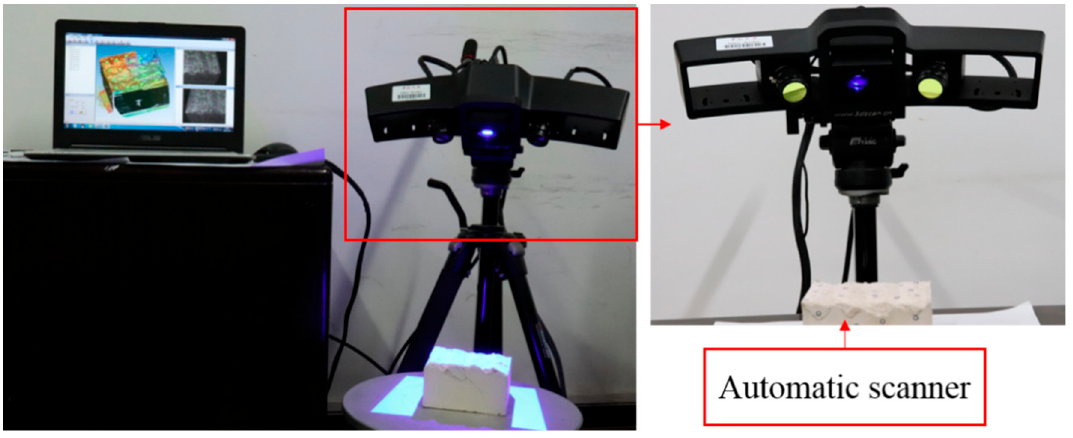
Figure 4. HL-3DS camera-type 3D scanner.